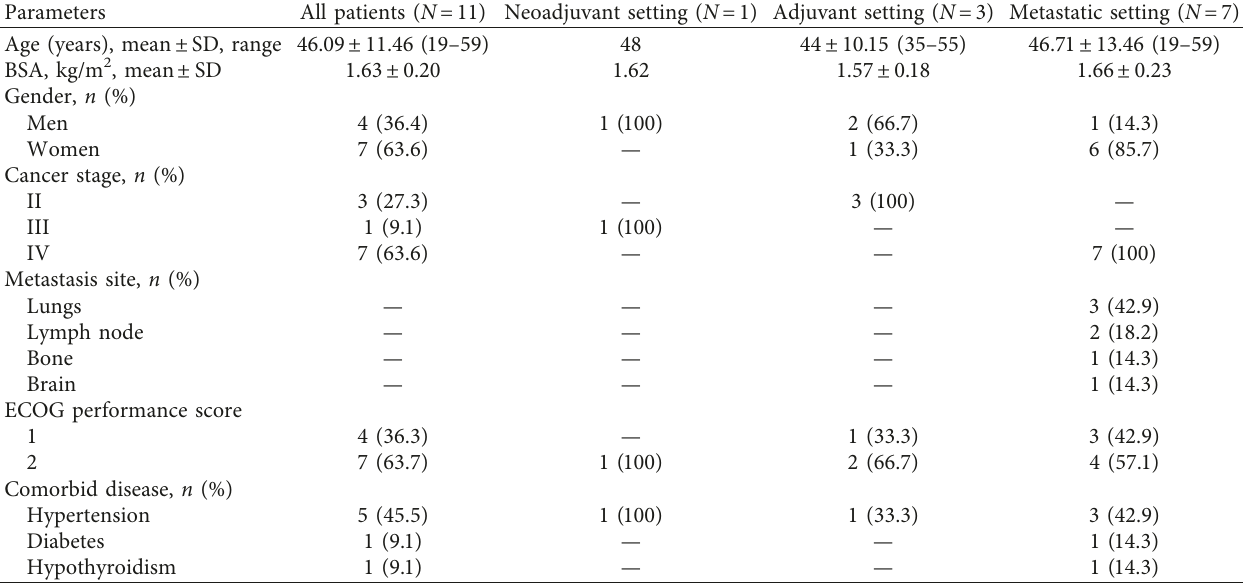
Table 1: Patient disposition and baseline characteristics.